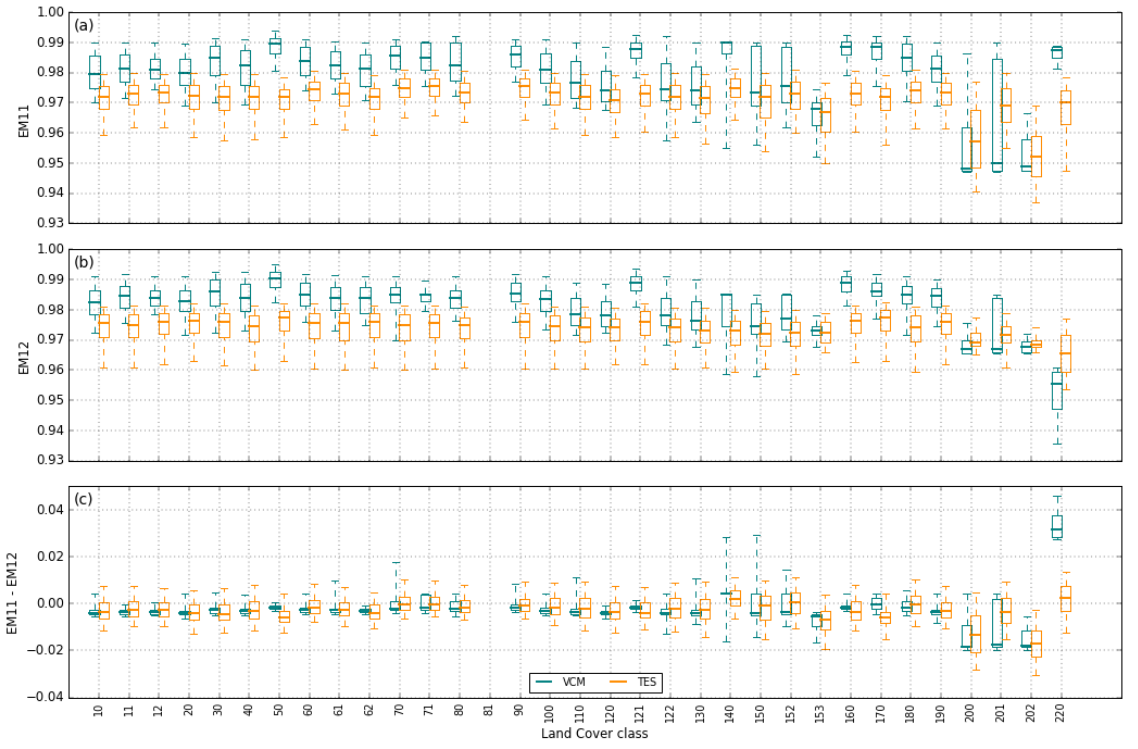
Figure 9. Distribution of ( a ) ~11 µm (EM11), and ( b ) ~12 µm (EM12) emissivities, and ( c ) the between-channel emissivity difference, for the VCM (green) and TES methods (orange), for each landcover type (as described in Table 1). The bold line represents the median, the box represents the 25th to 75th percentiles, and the whiskers represent the 5th and 95th percentiles.